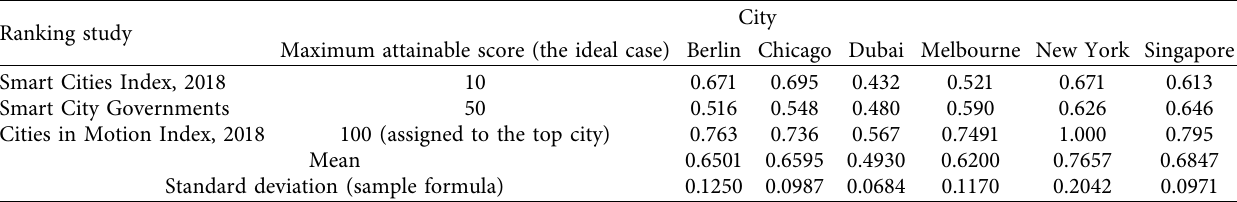
Table 5: Normalized scores of the 6 common cities in the 3 ranking studies dated 2018.